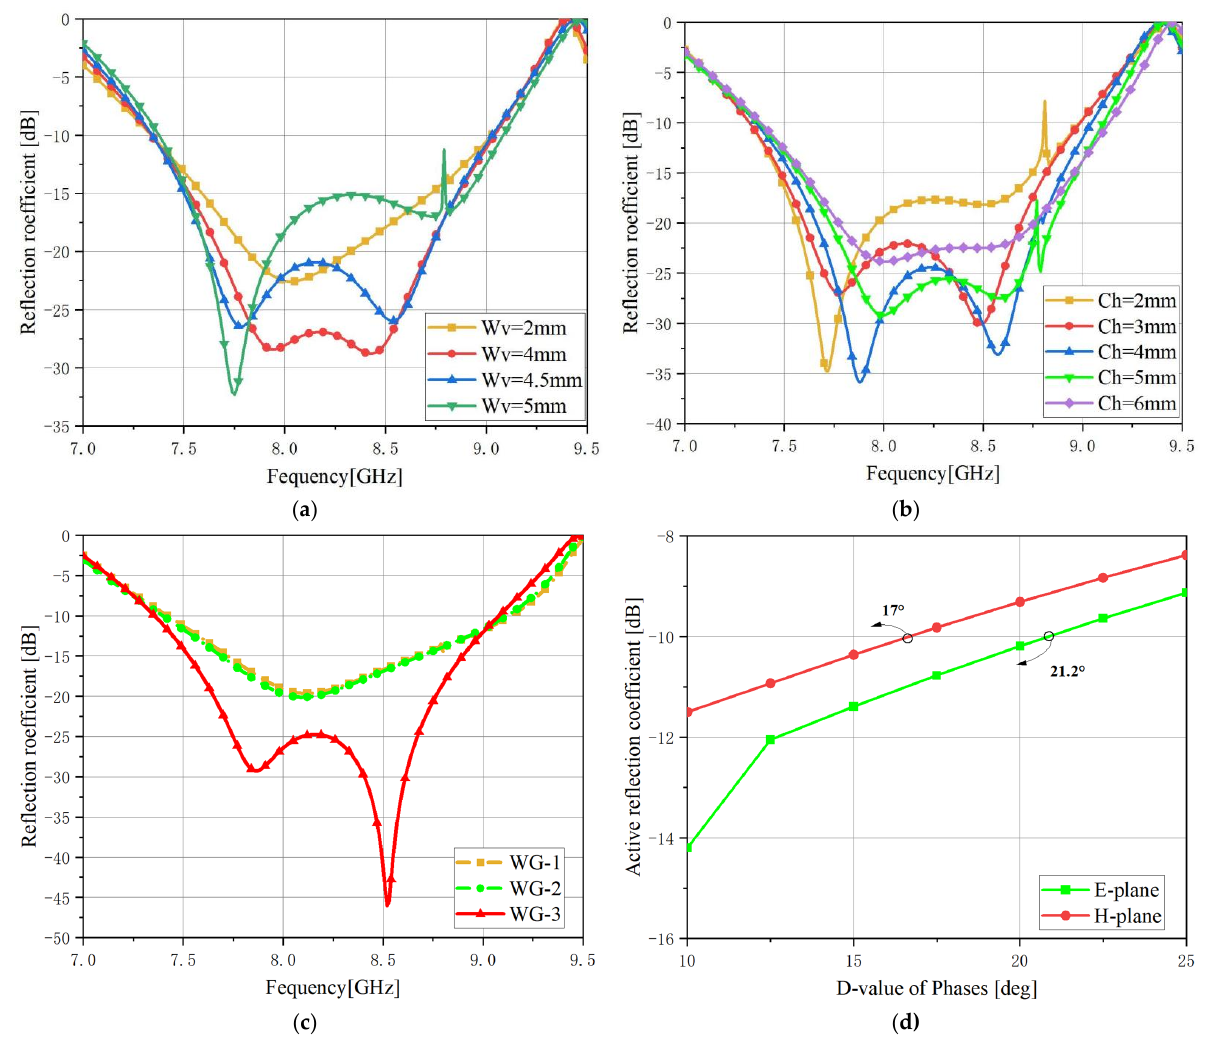
Figure 6. ( a ) The sensitivity analysis of parameter Wv , ( b ) the sensitivity analysis of parameter Ch , ( c ) the reflection coefficient of the curved waveguide, and ( d ) the reflection coefficient with the different D-values of phases.